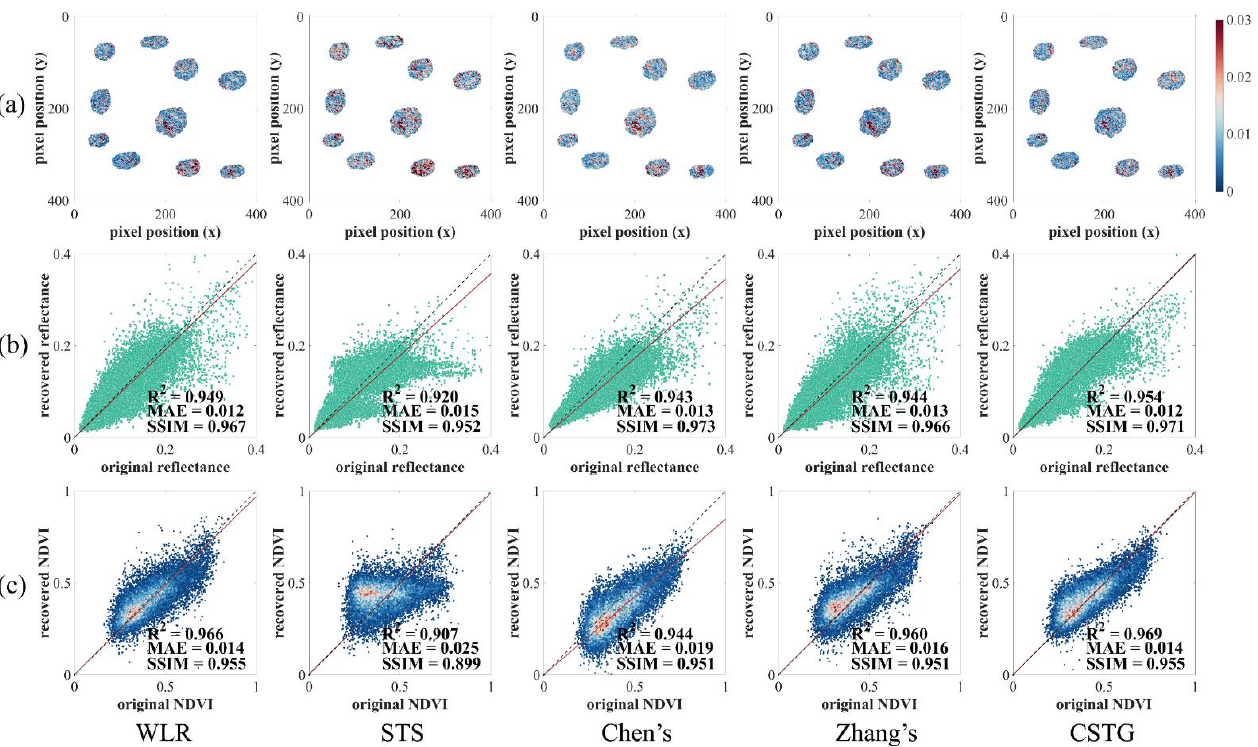
Figure 7. Visualization maps of quantitative analysis between recovered and original values using different methods at small and dispersive missing areas: ( a ) pixel-level error maps; ( b ) the regression analysis of the normalized reflectance; ( c ) the regression analysis of the NDVI. In ( b , c ), the solid red lines denote the regression lines and the dashed black lines denote the 1:1 lines.